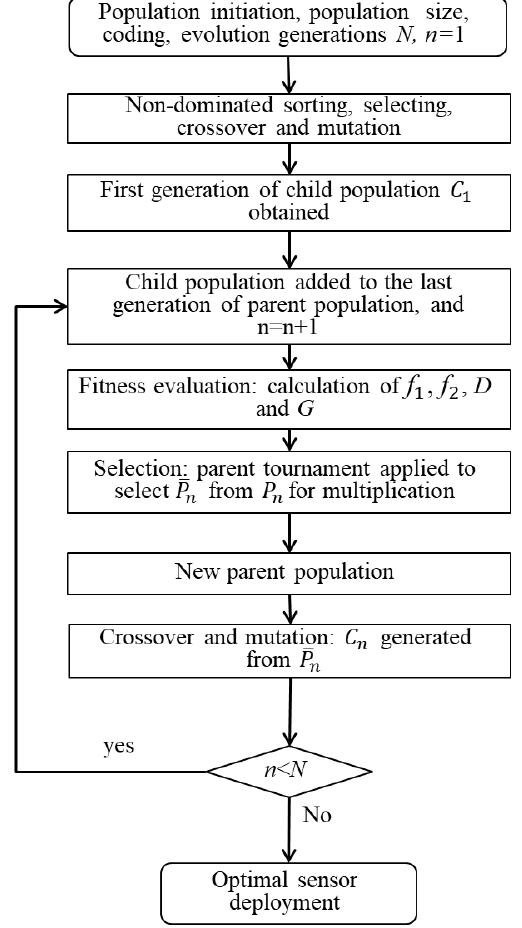
Figure 4. NSGA-II based Pareto bi-objective optimization.